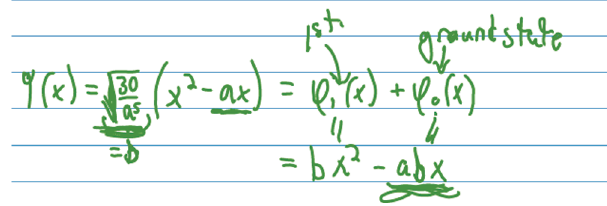
FIG. 3. Jack ’ s written response during the